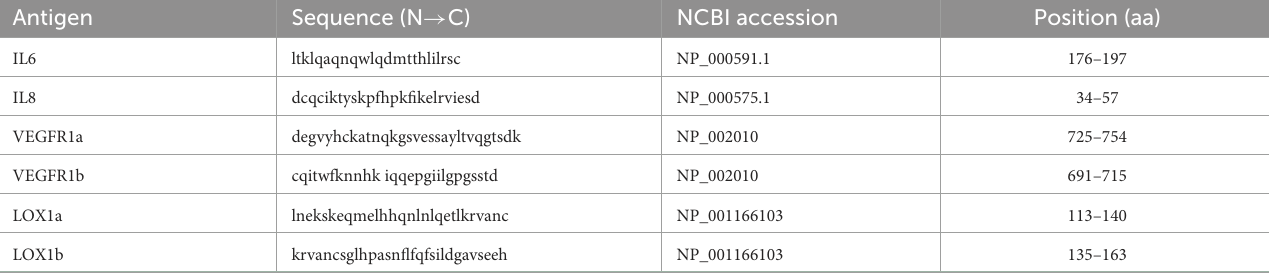
TABLE 1 The sequence information for peptide antigens used for the development of ELISA for antibody test.